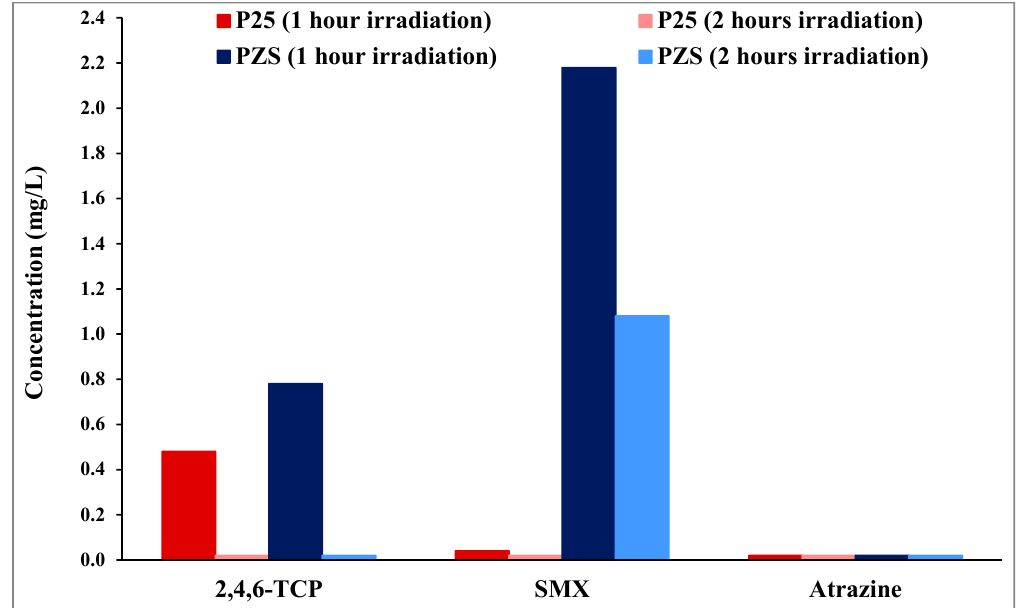
Figure 2. Residue results of the substrates on the surface of PZS and Degussa P25 after one and two hour irradiation. The left bar shows 1-h data and the (clearly visible only for SMX) right bar 2-h